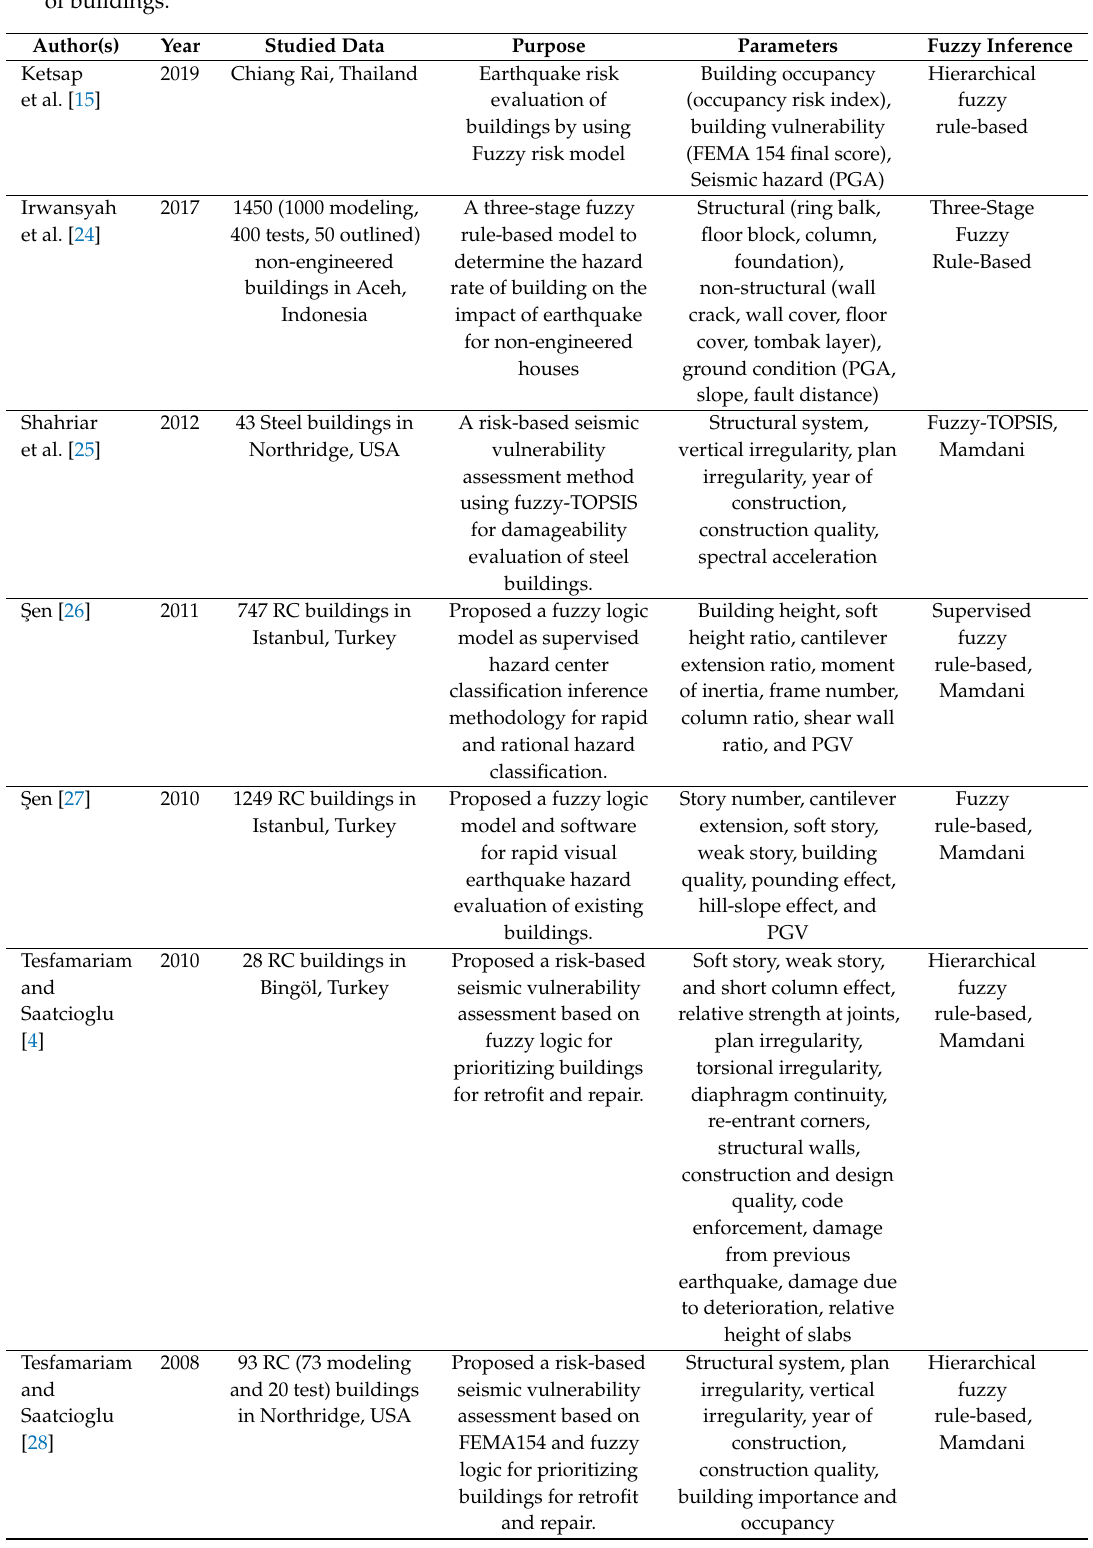
Table 1. Summary of Fuzzy Logic application in visually earthquake hazard safety assessment of